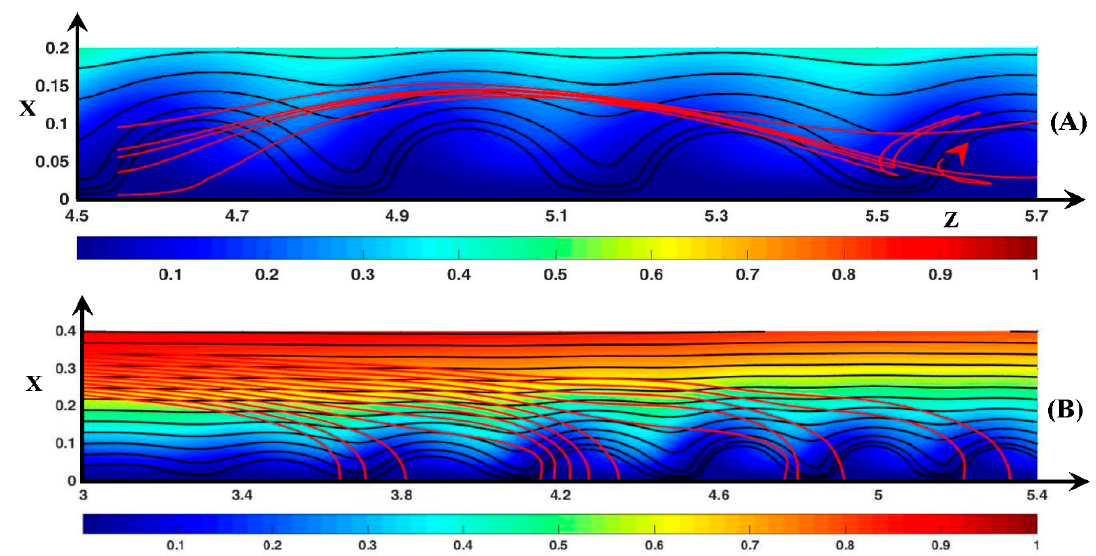
Figure 15. Fluid and ionic trajectories. Red lines: ( A ) anionic dynamic streamlines starting from z o = 4.55 ( x o = 0.005, 0.045, 0.055, 0.065, 0.1). The red arrow represents the position of the vortex at time t ’ (this vortex is downstream the trajectories source at t ’ = 0); ( B ): cationic dynamic streamlines starting from z o = 3, x o = [0.23, 0.35]. Black lines: fluid static streamlines starting from the inlet. Color plot: cation concentration. t ’ = 275. ∆Φ = 22, ν = 1/3 × 10 − 3 , 1 D .